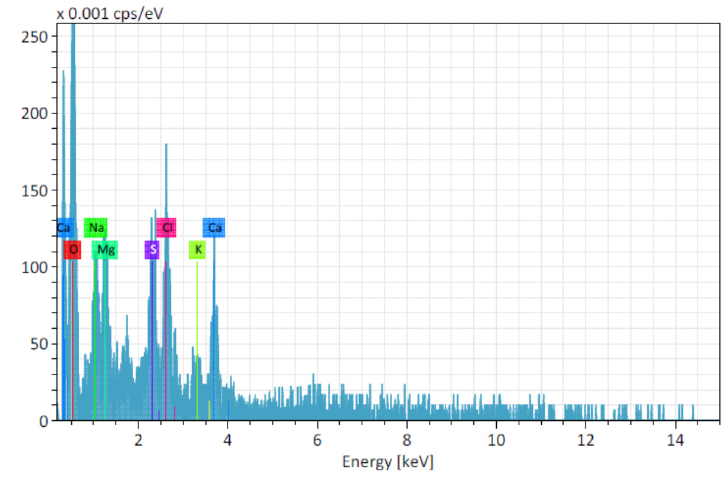
Figure 3. SEM-EDX—Energy Dispersive Spectrum of U. flexuosa showing the presence of various elements in their cell wall.